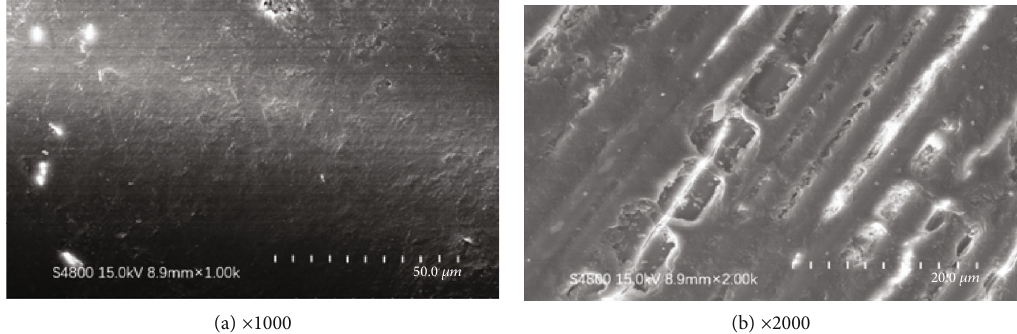
Figure 4: SEM of surface of MDPES-2 composite after thermal treatment at 500 ° C for 30 min.